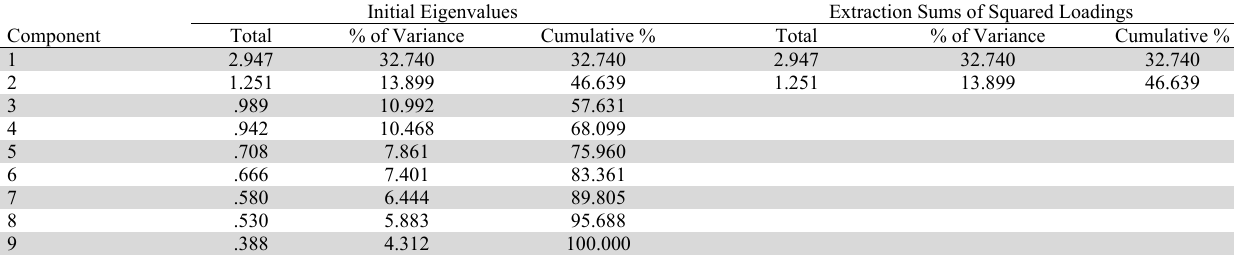
The total cumulative variance